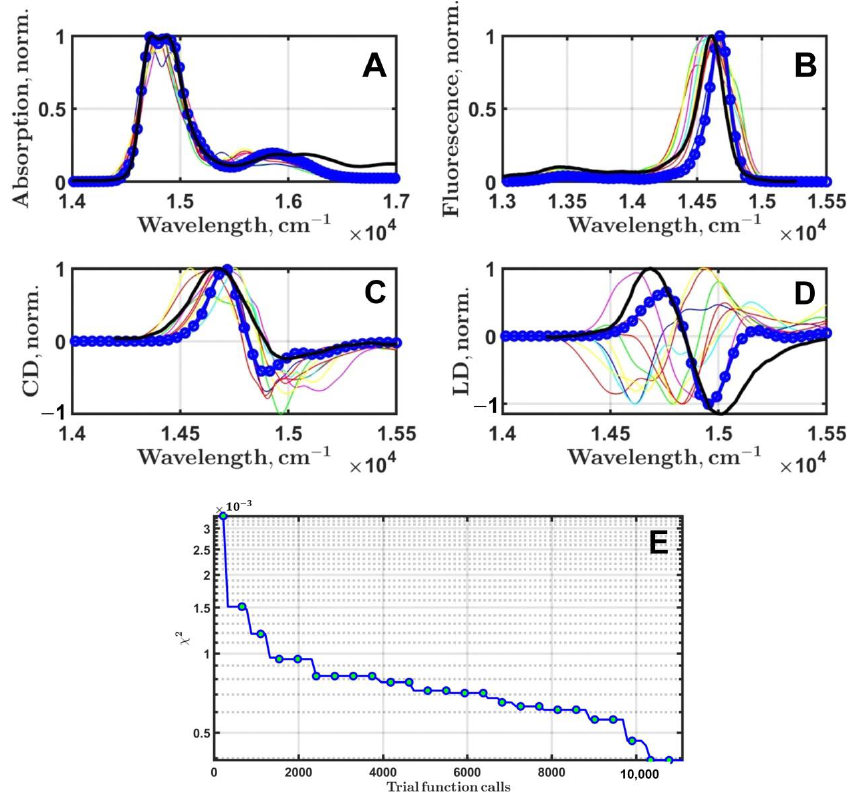
Figure 4. Fitting of the PSIIRC linear optical spectroscopy measured at 77 K. Black thick lines are the experimental spectra. The best results of optimization (blue lines with circular markers) for absorption ( A ), steady-state fluorescence ( B ), circular ( C ), and linear ( D ) dichroism are presented. Thin, colored lines are the simulated spectra found by DE after the first 10 generations. χ 2 evolution during 100 generation of DE ( E ).